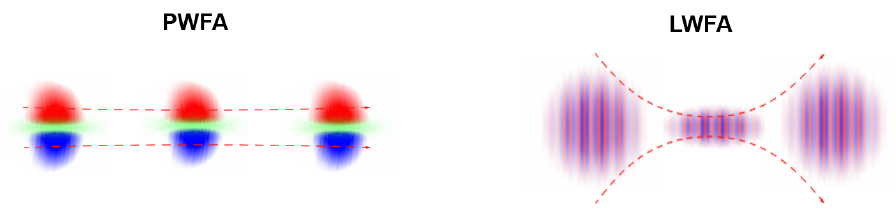
Figure 6. An electron beam of typical energy and emittance stays focussed over much longer length than a typical laser pulse, focused to the same spot